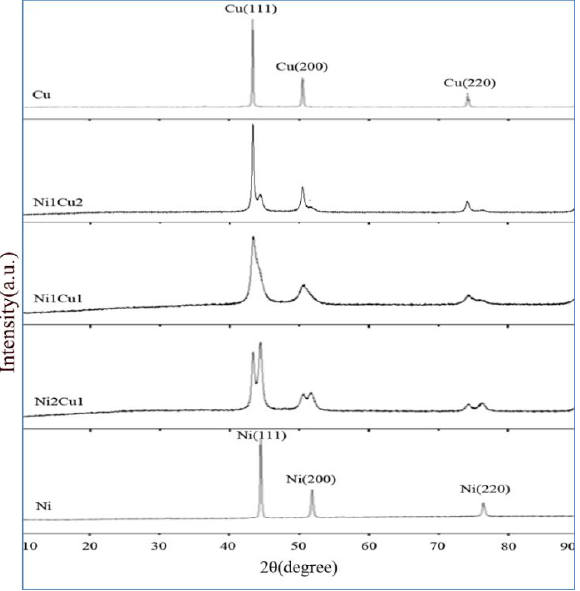
Figure 5: XRD patterns of Ni, Ni2Cu1, Ni1Cu1, Ni1Cu2, Cu nanoparti- cles.